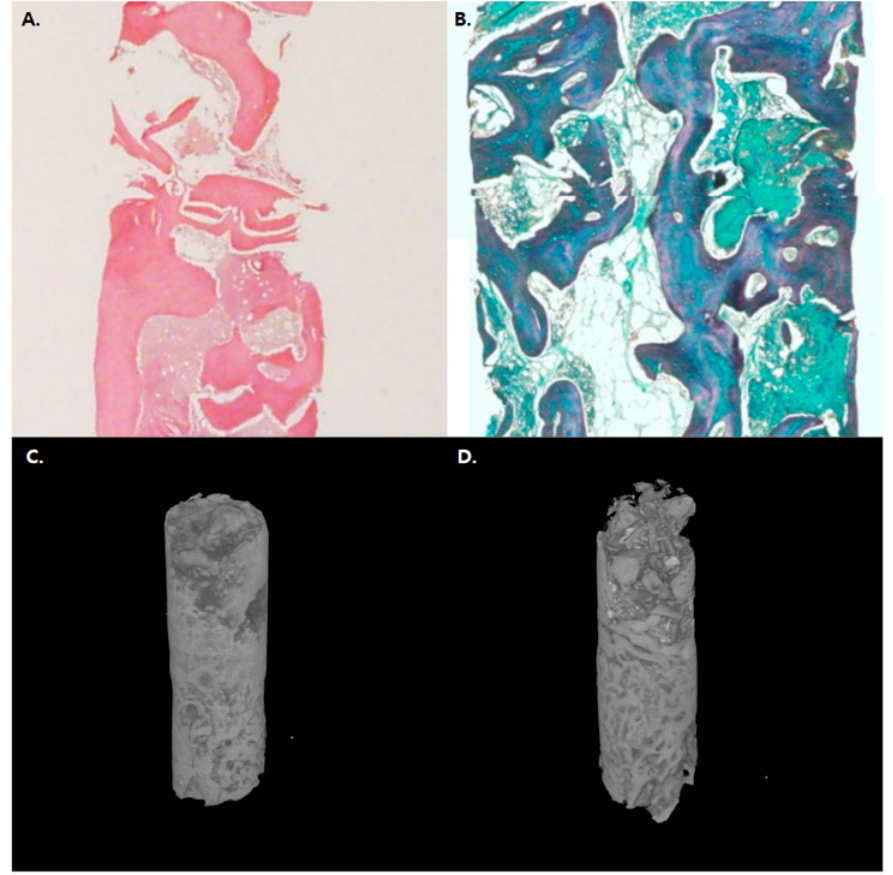
Figure 4. Histologic and microCT evaluation of the bone; representative histologic images of ( A ) TEG group HE staining and ( B ) control group MT staining. ( C ) 3D-reconstructed microCT image of TET group. ( D ) 3D-reconstructed microCT image of the control group showing favorable osteogenesis and osteoconduction.